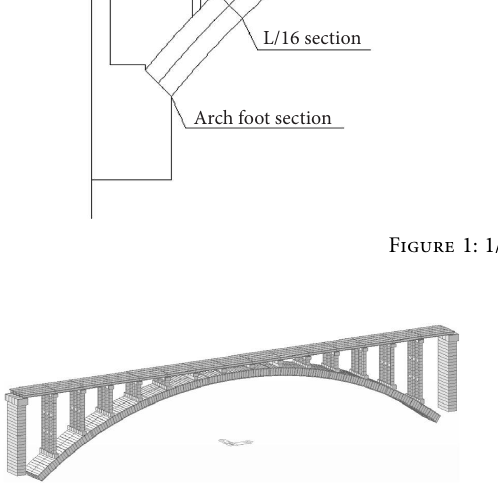
Figure 2: Te fnite element model of the arch